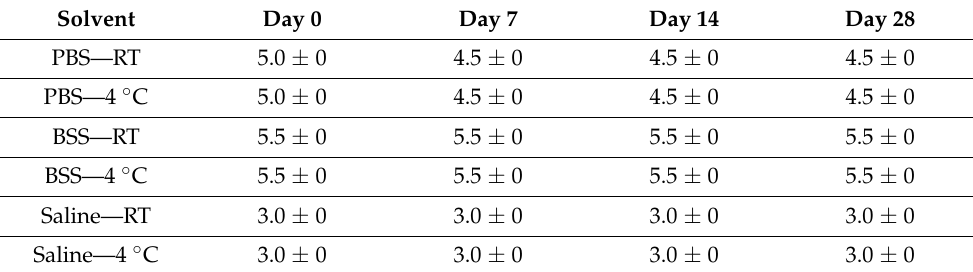
Table 1. The pH of vancomycin formulations in phosphate-buffered saline (PBS), balanced salt solution (BSS), and normal saline immediately after formulation and then at days 7, 14, and 28 after storage at room temperature or under refrigeration. RT: room